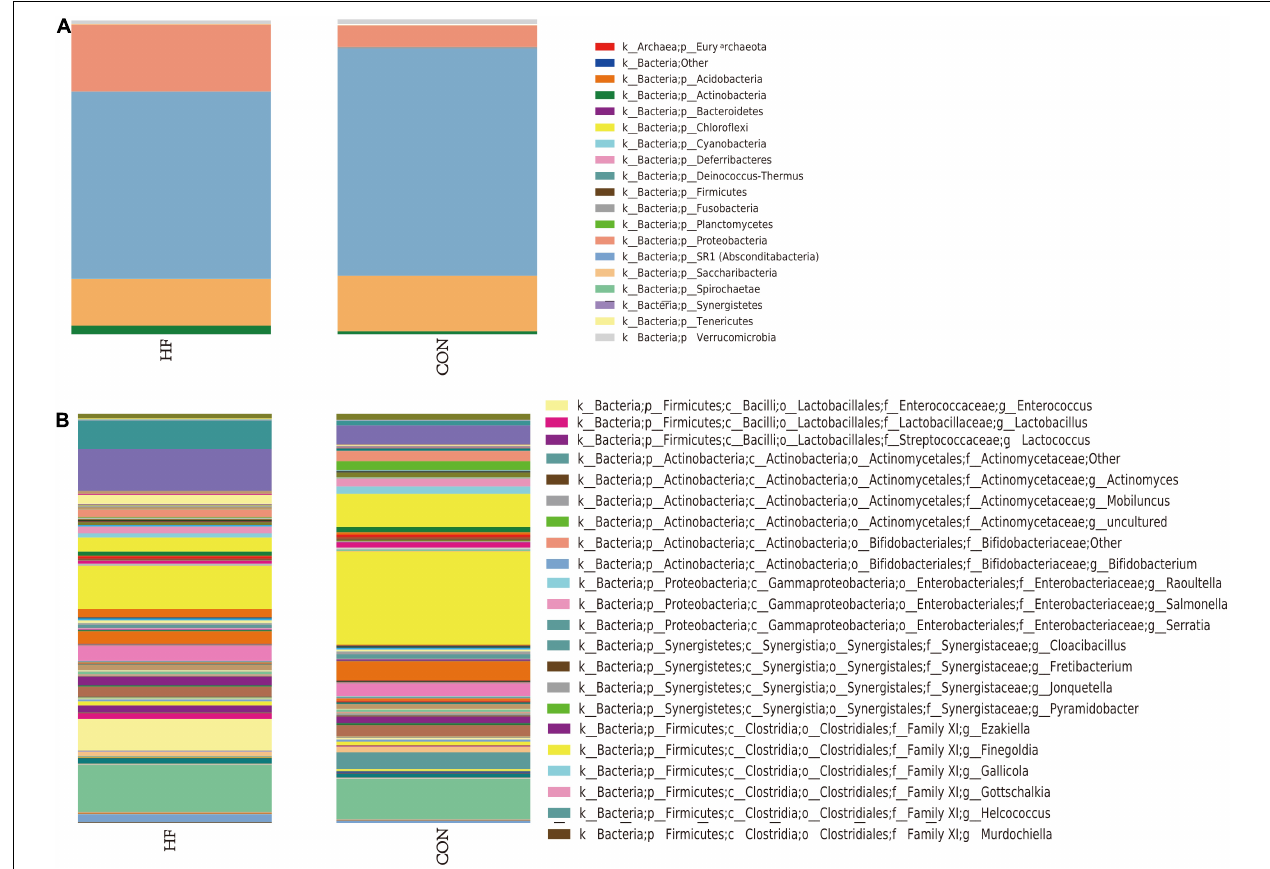
FIGURE 1 | The distribution of relative abundance in the CHF and the healthy control group. Panel (A) shows the distribution of relative abundance of top 19 at phylum level in the two groups. Panel (B) shows the distribution of relative abundance at the genus level in the two groups. HF, CHF group; CON, the healthy control